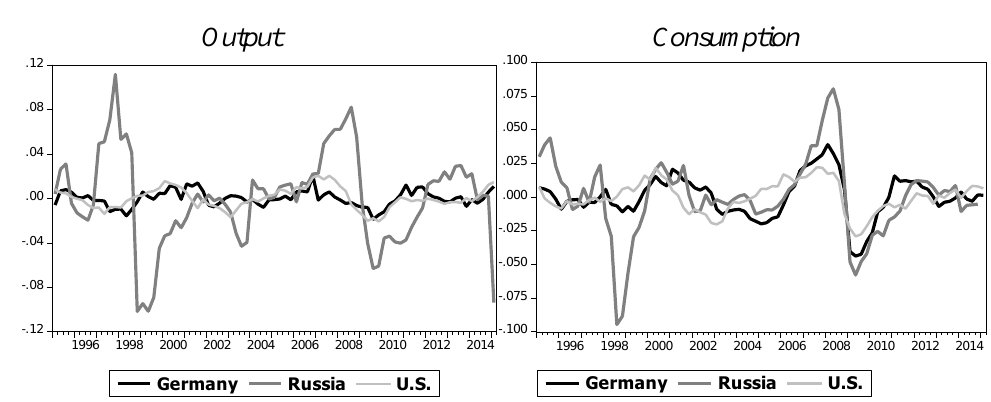
Fig. 4. Partner output and consumption